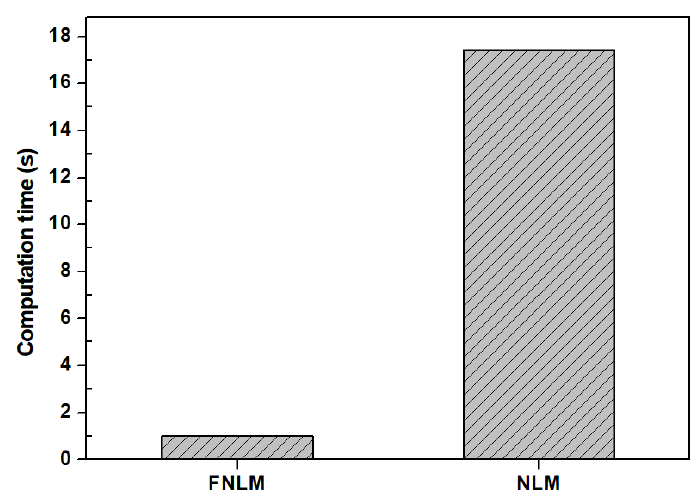
Figure 10. Comparison between the time resolutions of the FNLM and non-local means (NLM) denoising algorithms.